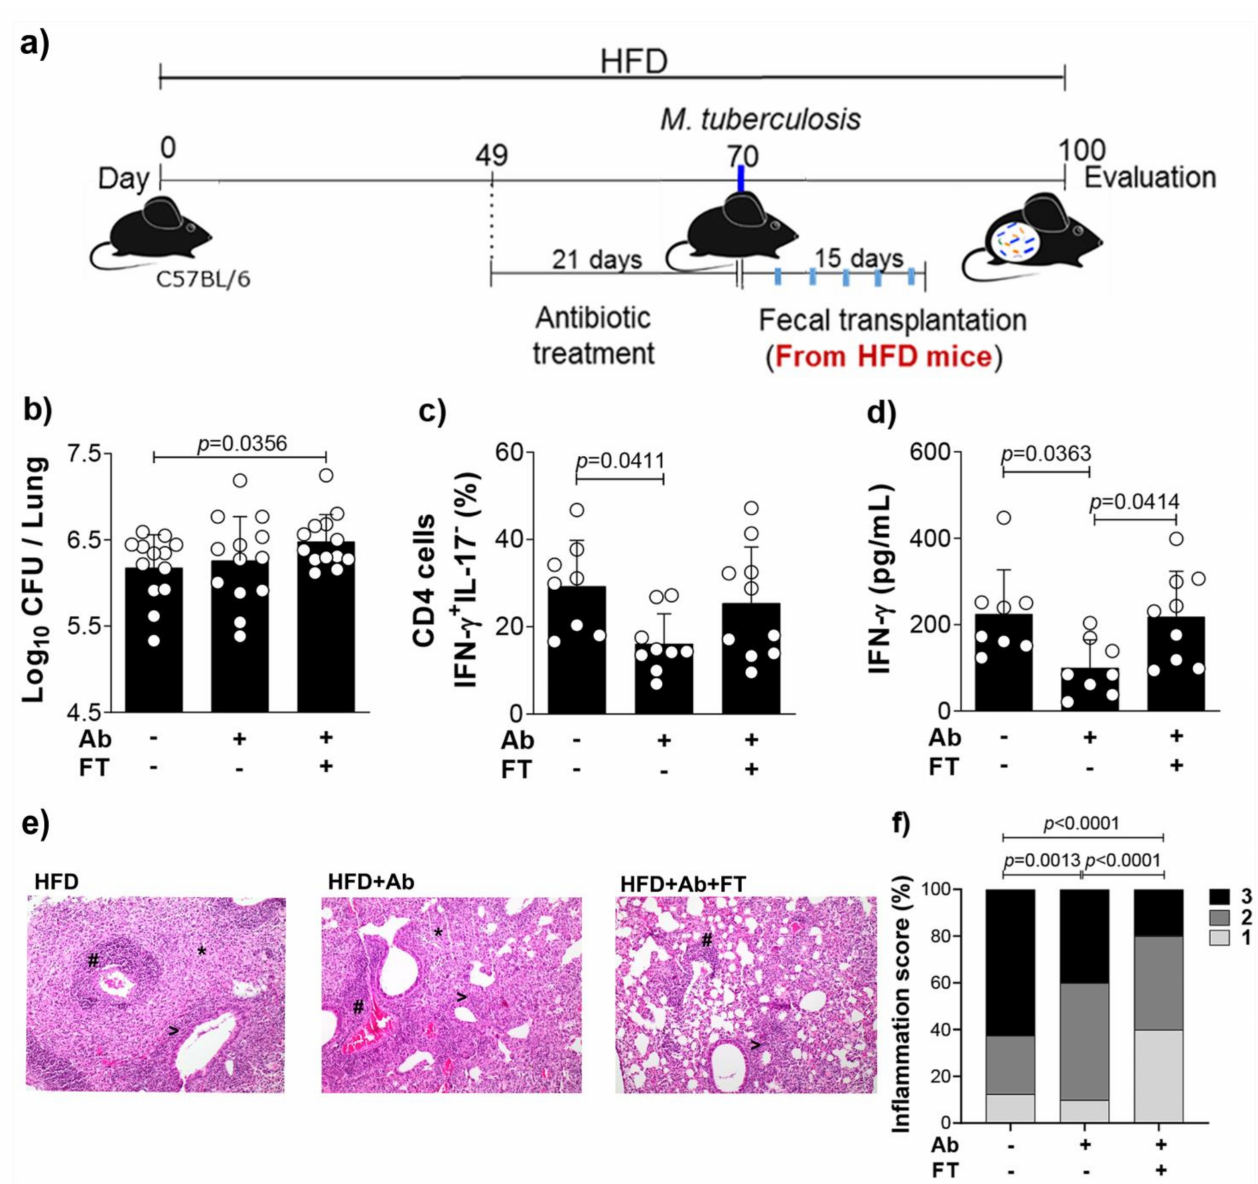
Figure 4. Microbiota depletion of obese infected mice reduces lung IFN- γ -producing CD4 + cells and IFN- γ levels. ( a ) Experimental protocol for microbiota depletion and fecal transplantation. Mice fed with HFD were treated or not with an antibiotic cocktail (Ab) for 21 days, infected with M. tuberculosis and transplanted (FT) or not with feces (30 mg per animal) from obese non-infected mice (5 doses, 3-day interval for 15 days). ( b ) Colony-forming unit (CFU) number, ( c ) frequency of lung CD4 + IFN- γ + IL-17 − cells and ( d ) IFN- γ levels in lung homogenates ( n = 8–10). ( e ) Representative lung sections stained with H&E (magnification 200 × ) (# perivascular infiltration, > peribronchial infiltration, * foamy macrophages) and ( f ) percentage of inflammation score (1 = mild; 2 = moderate; 3 = severe). Data are representative of two independent experiments and are expressed as means ± SD. Bars show the significant difference between groups ( p <